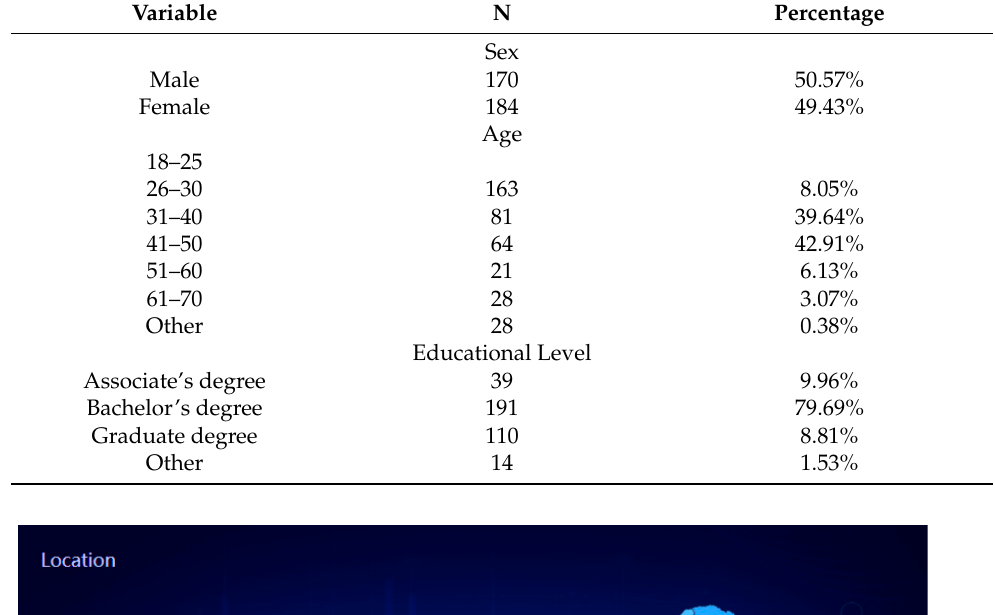
Table 2. Profile of survey respondents (n = 261).